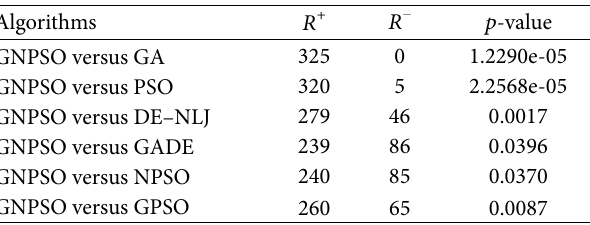
Table 9: Wilcoxon signed ranks test results for the control perfor- mance of nonlinear wing vibration system obtained by different al- gorithms.